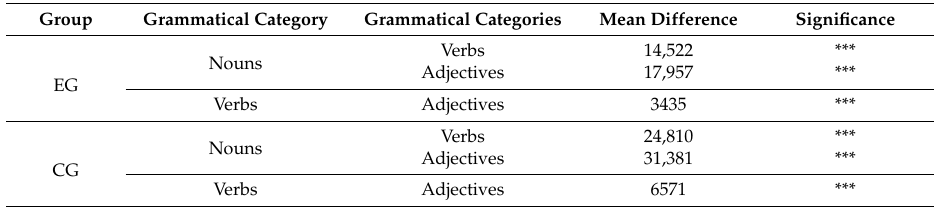
Table A3. Nouns, verbs and adjectives with the 10 highest frequencies per group of speakers.